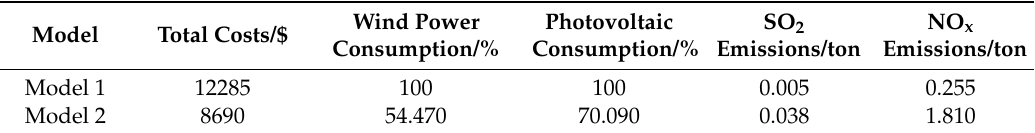
Table 11. Scheduling results comparison of two models.